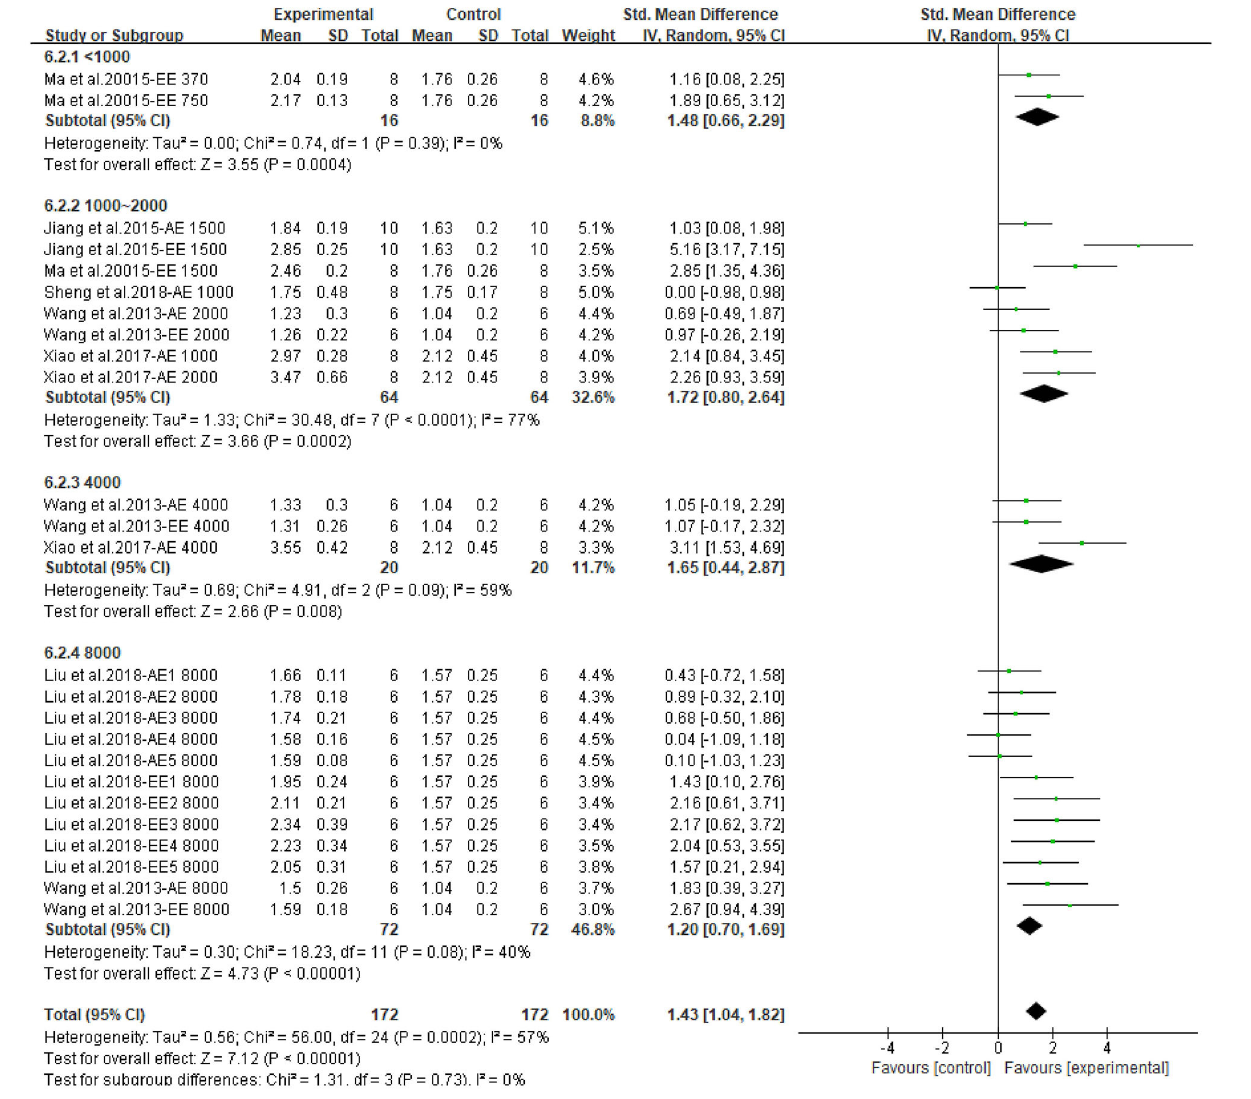
NIT-1 cells (8, 9), which are a pancreatic β cell line established from mice